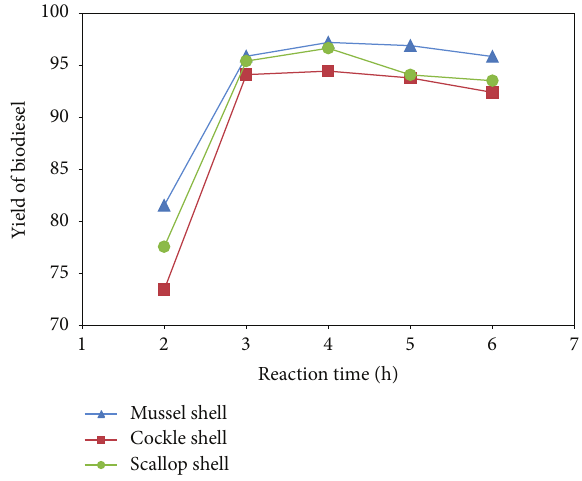
Figure 5: Effect of reaction time on % yield of